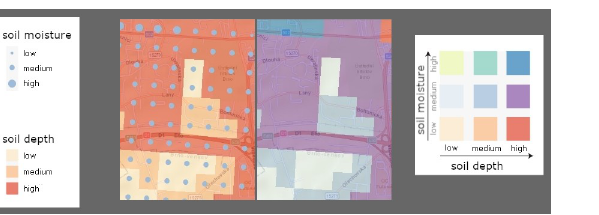
Fig 2. Examples of extrinsic visualization (left) and intrinsic visualization (right) used in the study. Legends for both extrinsic and intrinsic visualization are also given. Areas with identical values are depicted with two different encoding systems to enable a visual comparison of the differences between each